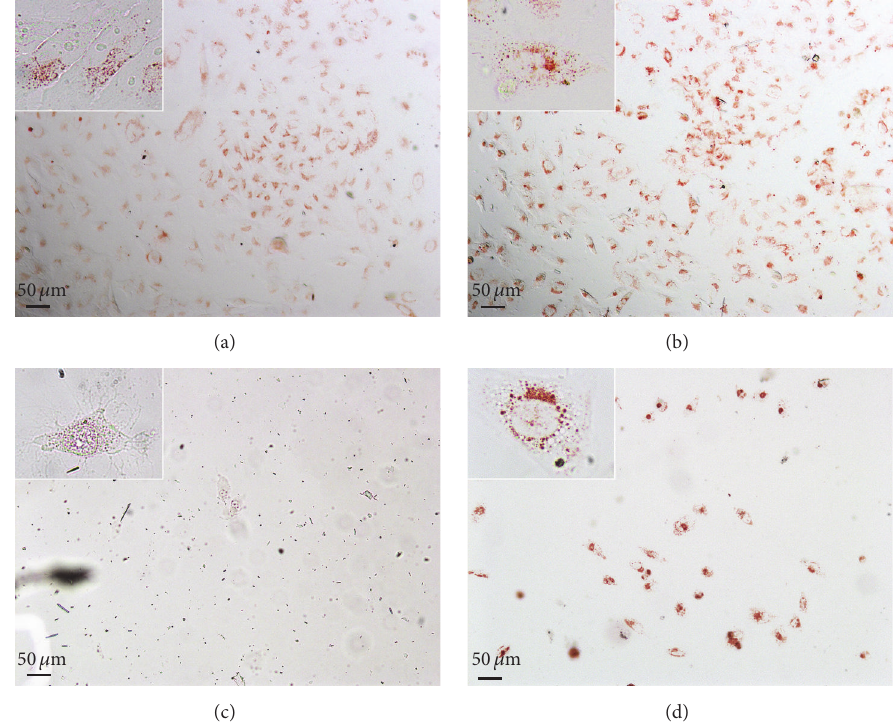
Figure 3: Effect of ILF on HeLa cells measured as NRU; all images at 100x magnification and 400x magnification at the upper left corner. Growth control w/o ILF (a), at 0.5 g/L (b), at 5 g/L (c), and at 5 g/L centrifugation (d). The recommended concentration for human consumption is 5 g/L (1x). Red stained cells indicate metabolic activity and functional